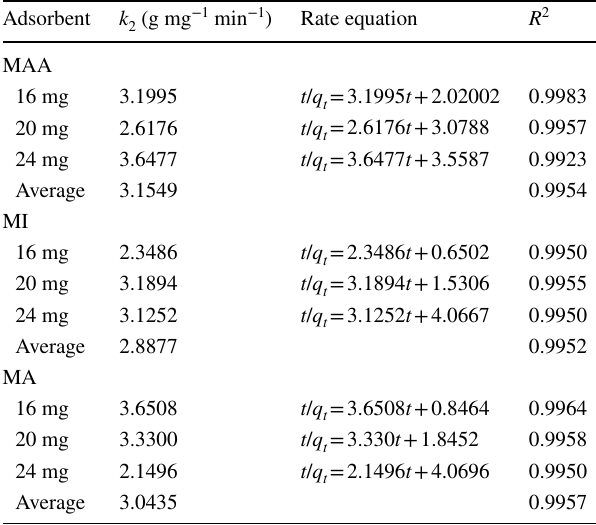
Table 3 Pseudo-second-order rate constants and the correlation coef- ficients along with the rate equations Adsorbent